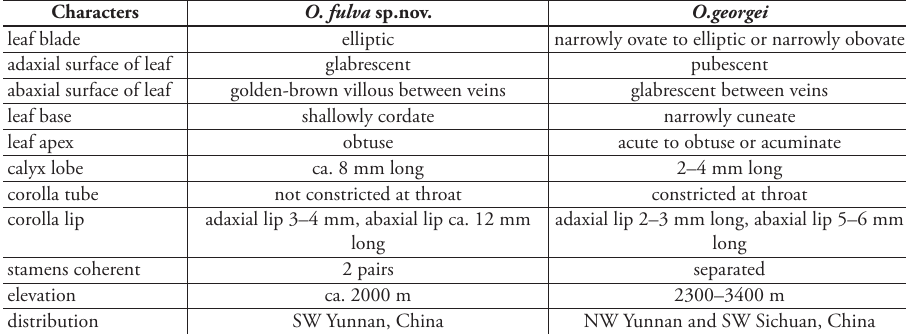
Table 2. Differences in characters between Oreocharis fulva and O.georgei in Gesneriaceae.